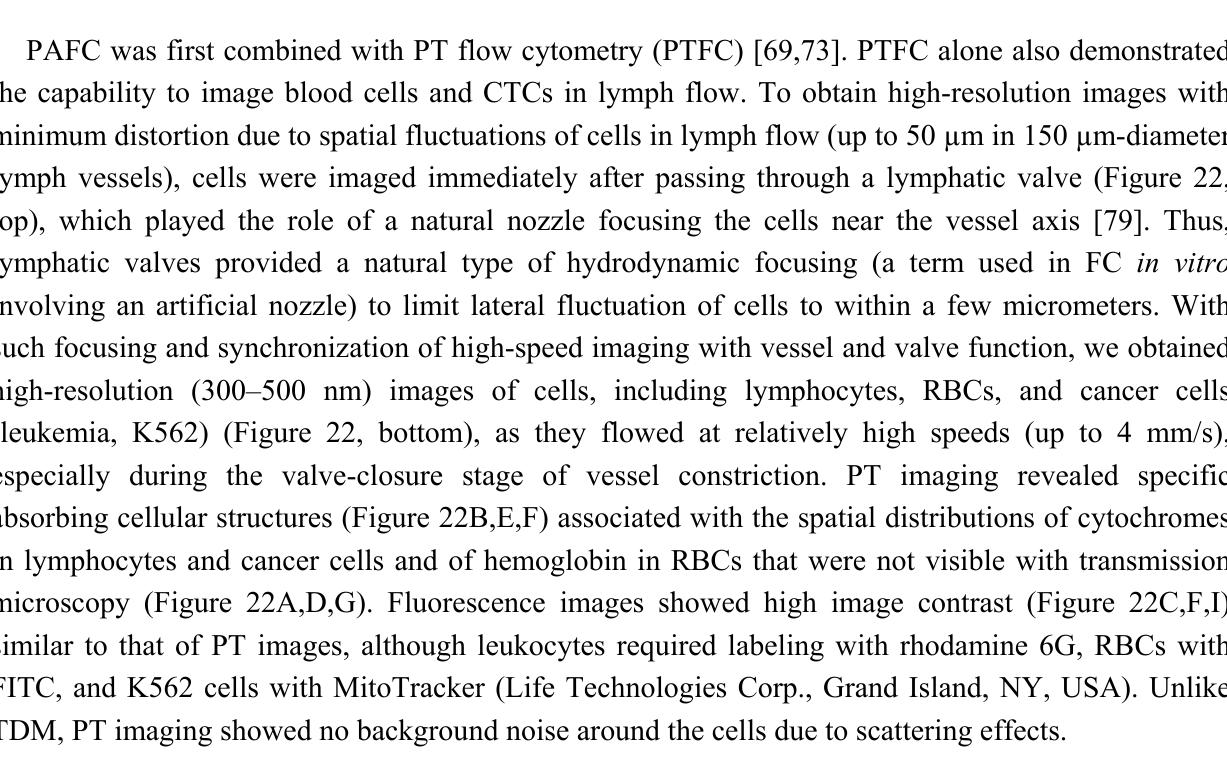
Figure 22. (Top) Schematic for the natural focusing of cells in lymph flow. (Bottom) transmission digital microscopy (TDM) ( A,D,G ), PT ( B,E,H ), and fluorescence ( C,F,I ) images of (top row) leukocytes, (middle row) RBCs, and (bottom row) K562 cancer cells in lymph flow in vivo